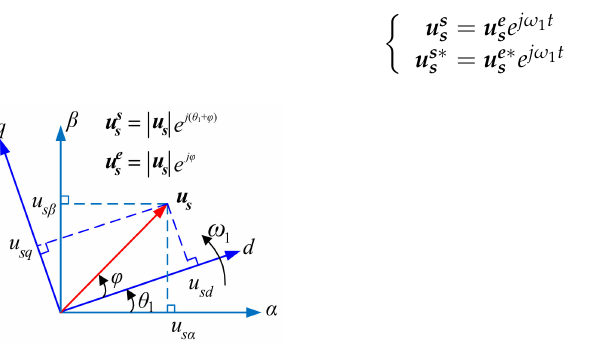
Figure 5. Voltage complex vector expressions in different coordinate